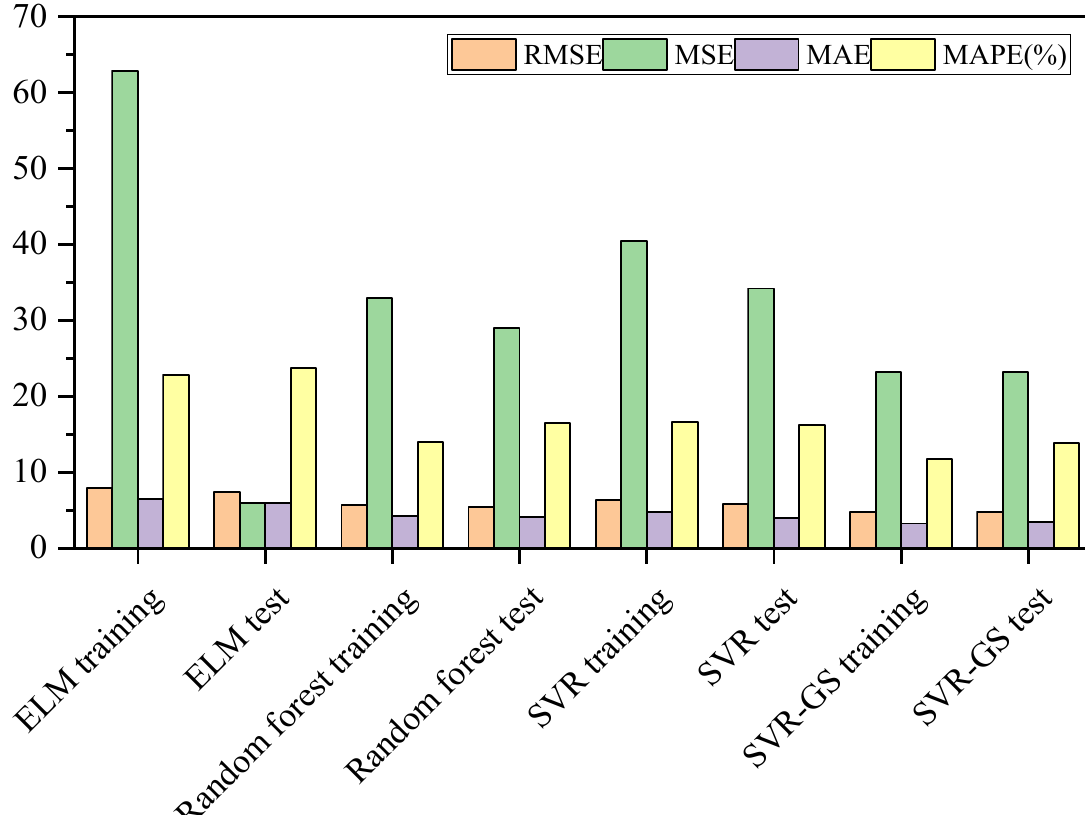
Figure 9. The performance criteria of the two models.